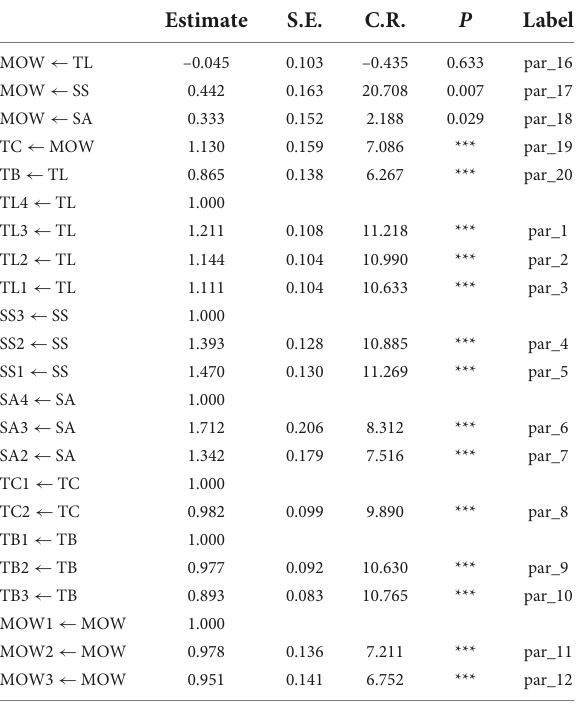
TABLE 3 CR value and probability on the confirmatory factor analysis (CFA) test.